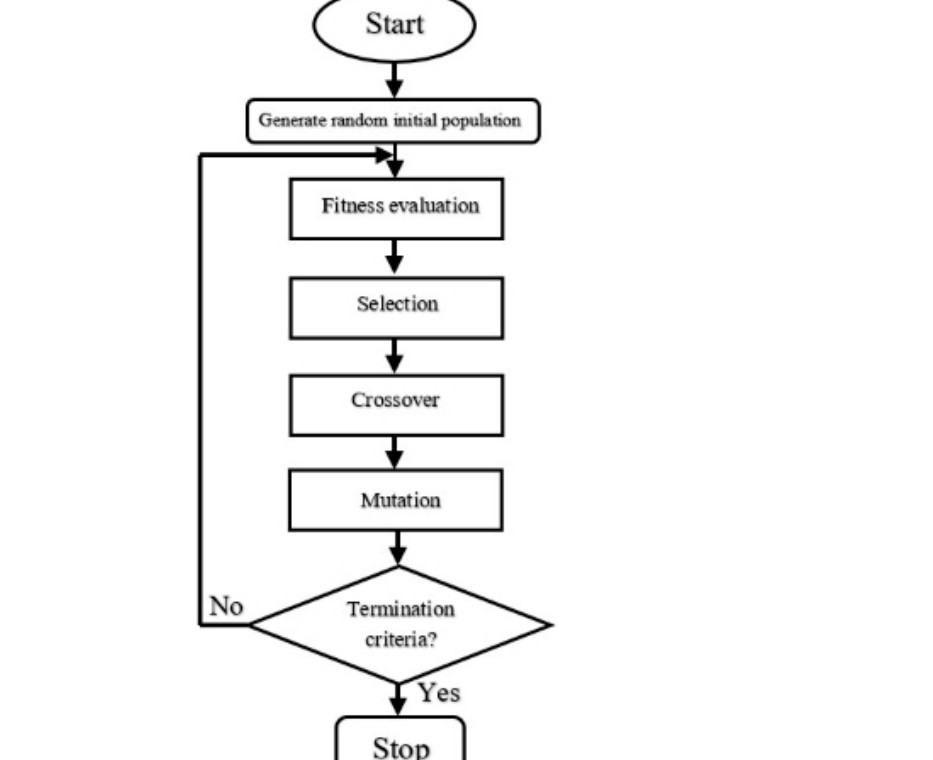
Figure 5. GA optimization flowchart.